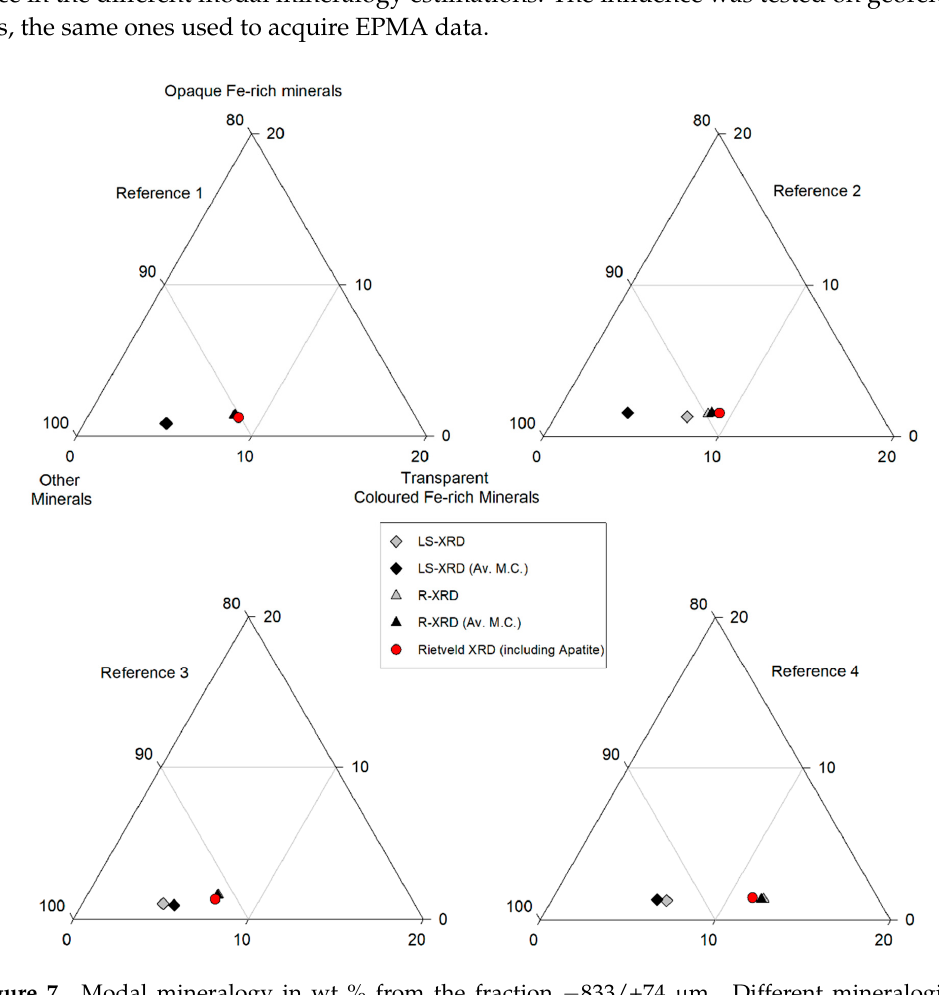
Figure 7. Modal mineralogy in wt % from the fraction − 833/+74 µm. Different mineralogical estimations using averaged mineral chemistry from the deposit and the specific mineral chemistry for the georeferenced data. Av. M.C. = average mineral chemistry.